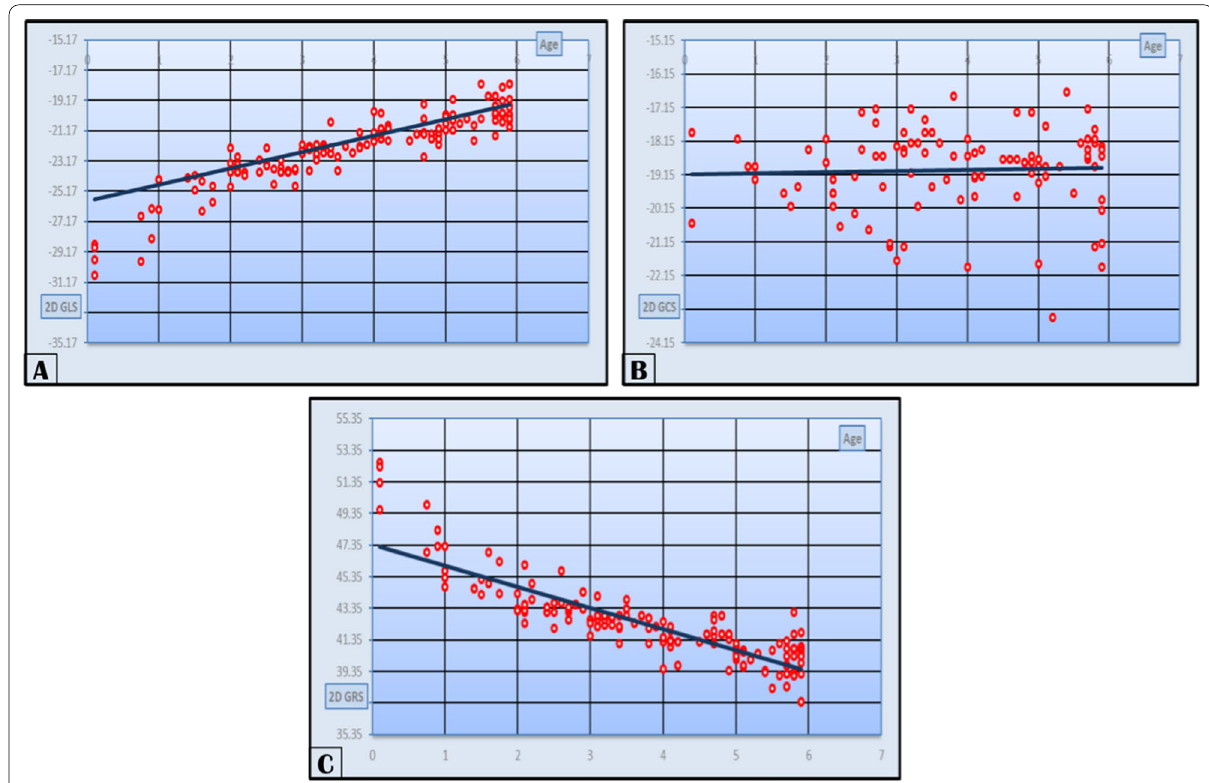
Fig. 3 Our study population 2D A GLS STE in relation to age, B GCS STE in relation to age, C GRS STE in relation to age